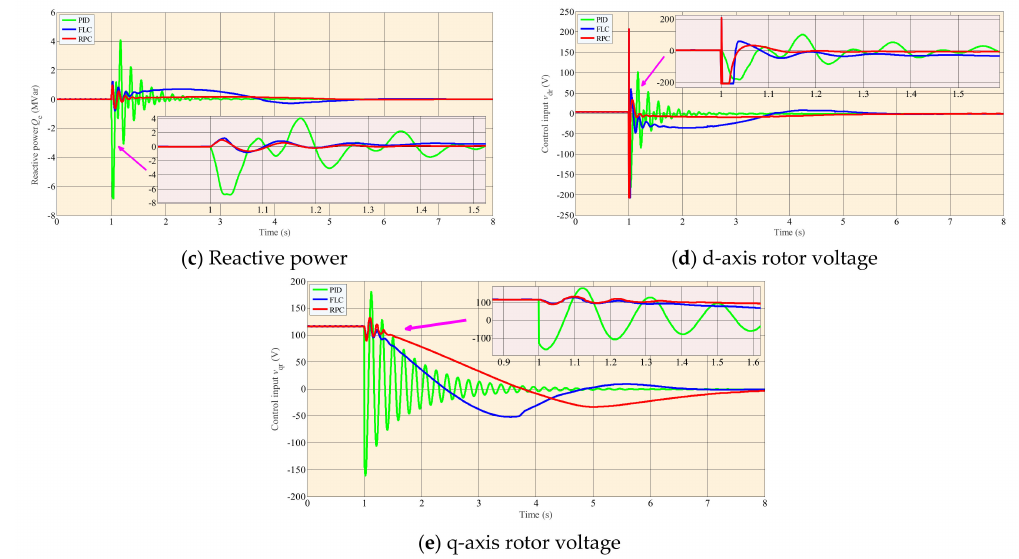
Figure 3. System responses and control costs obtained under a step change of wind speed from 10 to 12 m/s with a fixed pitch angle of 15 deg. ( a ) wind speed profile; ( b ) active power; ( c ) reactive power; ( d ) d-axis rotor voltage; ( e ) q-axis rotor voltage.